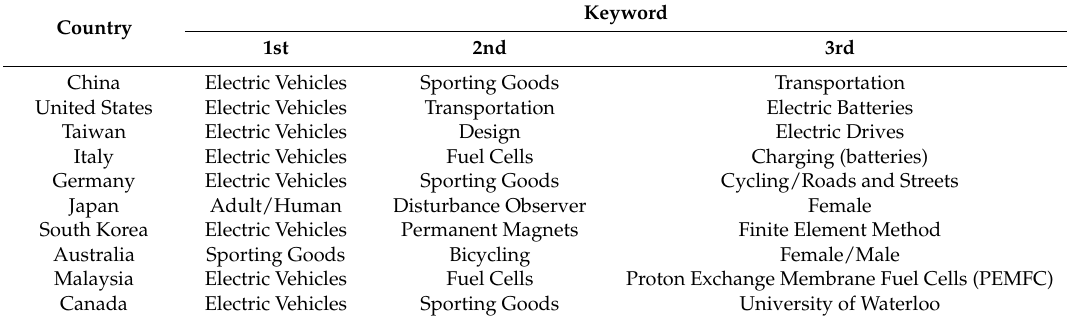
Figure 6. Cloud word of the whole keywords related to electric bicycle. Table 2. Main keywords used by countries most productive.